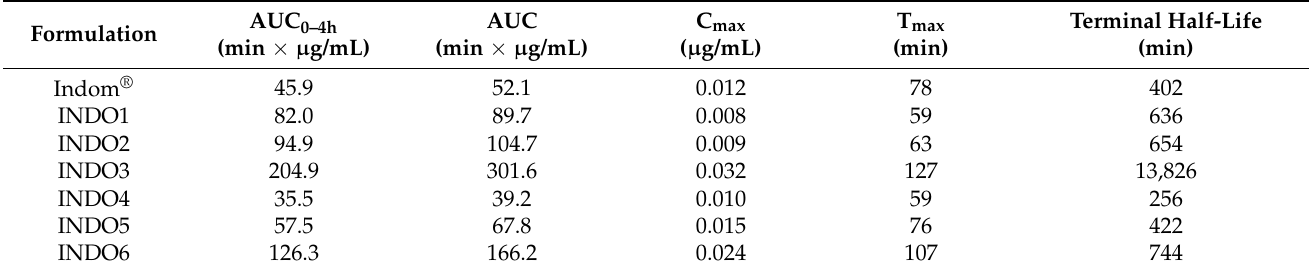
Figure 3. Indomethacin concentrations in the rabbit aqueous humor after topical administration of the suspensions. The results represent the mean ± SEM values in the small ( Left ) and large particle ( Right ) suspensions. The commercial indomethacin suspension (Indom ® ) is included in both figures for reference. Table 6. Pharmacokinetic parameters of topically applied indomethacin in the rabbit aqueous humor. AUC is the area under the curve until infinity.